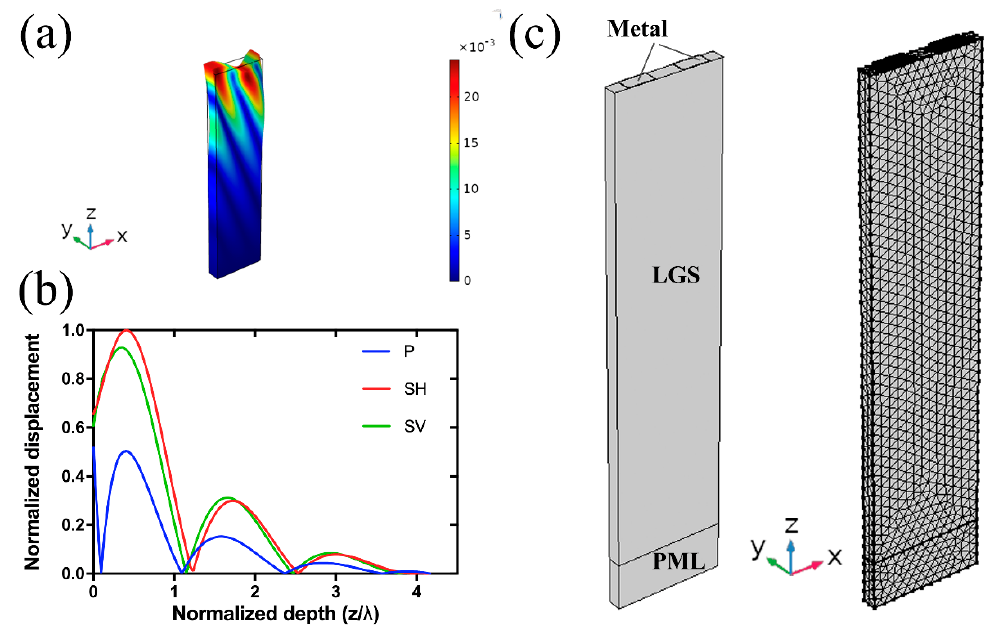
Figure 2. Vibration shape ( a ) and displacement distribution ( b ) of P, SH, and SV wave components of a SAW device ( 𝜆 = 12 μm ) based on LGS (0 ° , 138.5 ° , 117 ° ); Geometry of the 3D periodic model of the proposed SAW device used in the modeling ( c ).